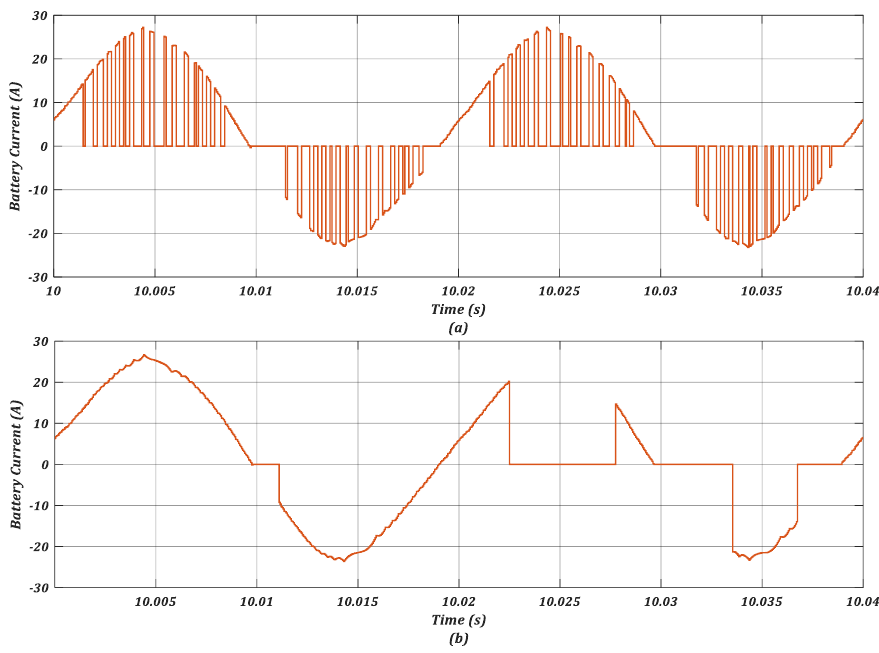
Figure 5. Typical individual battery current switching when: ( a ) SOC is sampled at the normal sampling frequency; ( b ) SOC is sampled once during a current half cycle.